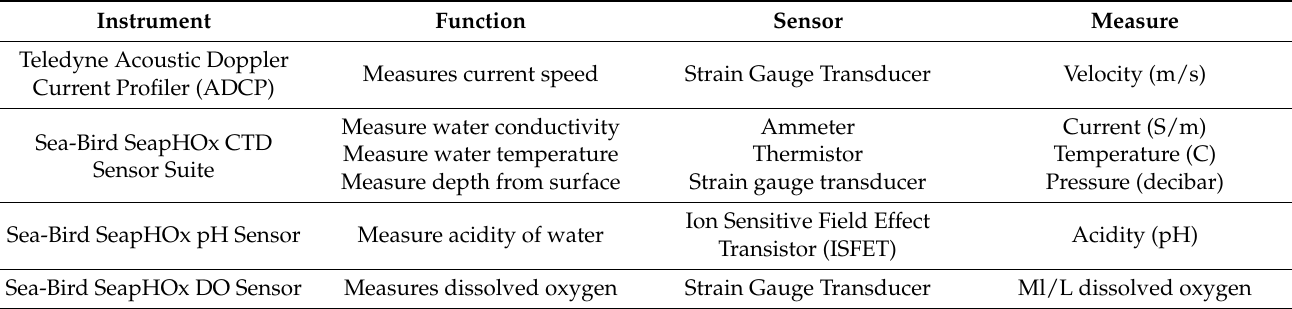
Table 1. Summary of instrument sensors covered in intervention lessons.